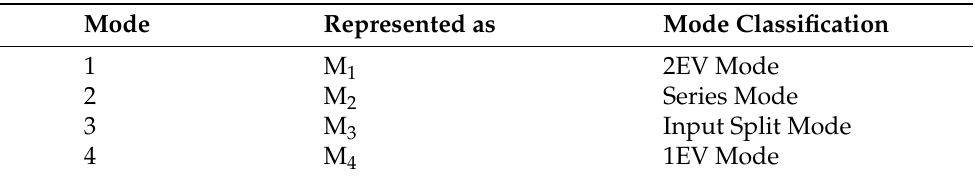
Table 2. Different modes of operation for 1-PG and 2-PG topologies.